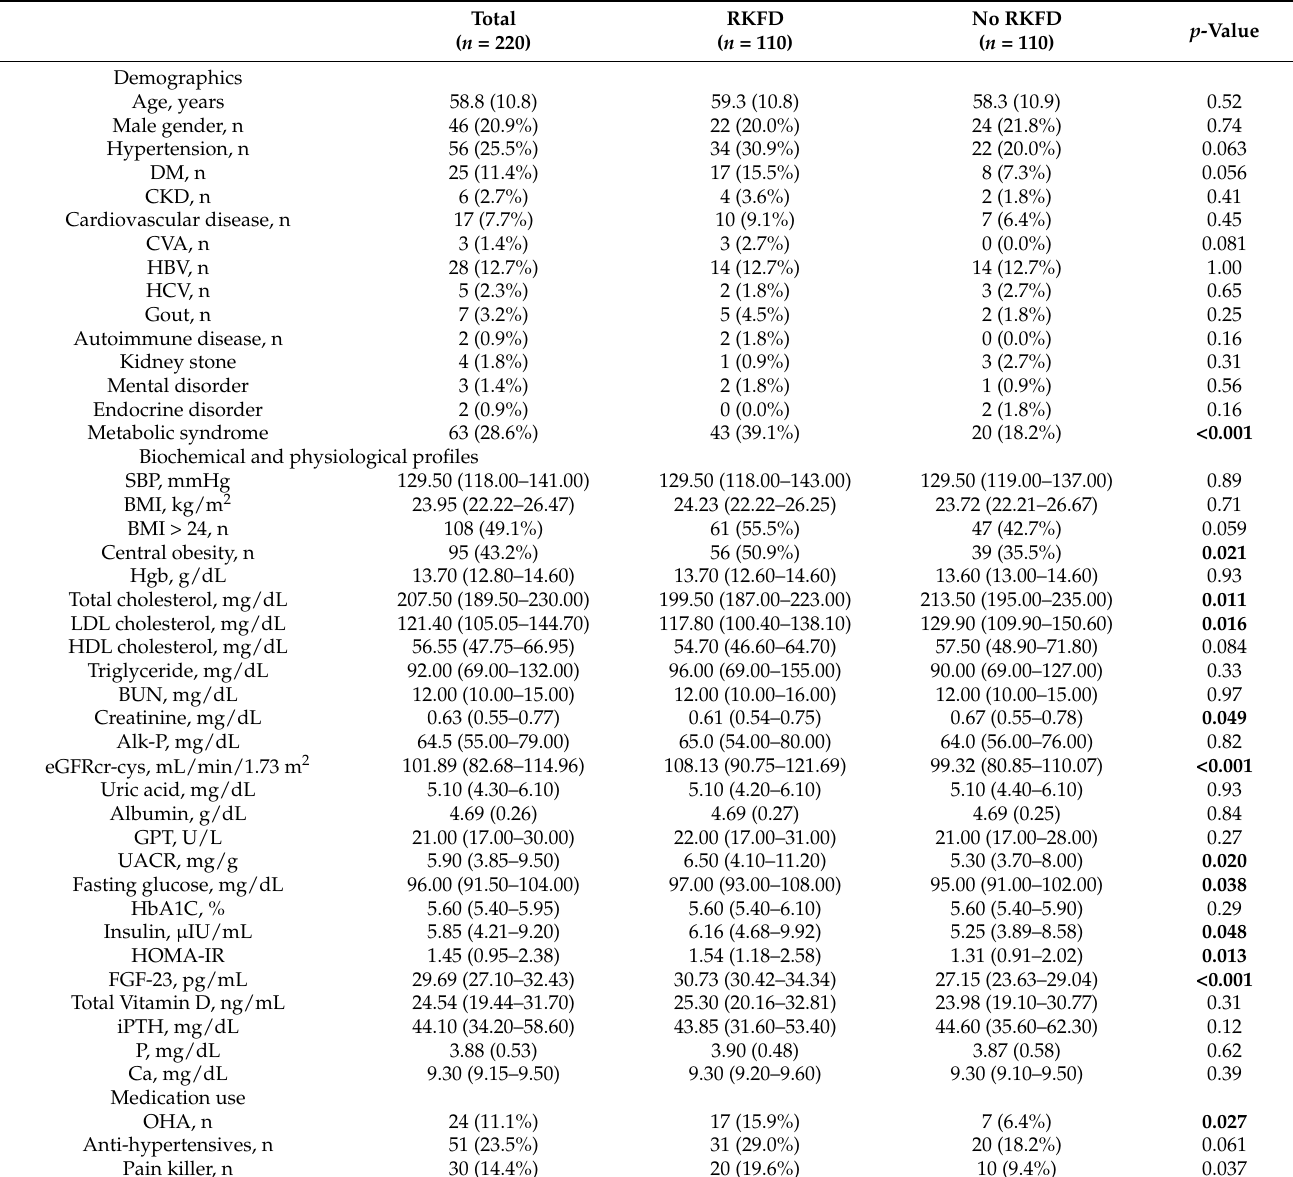
Table 1. Baseline characteristics of the study